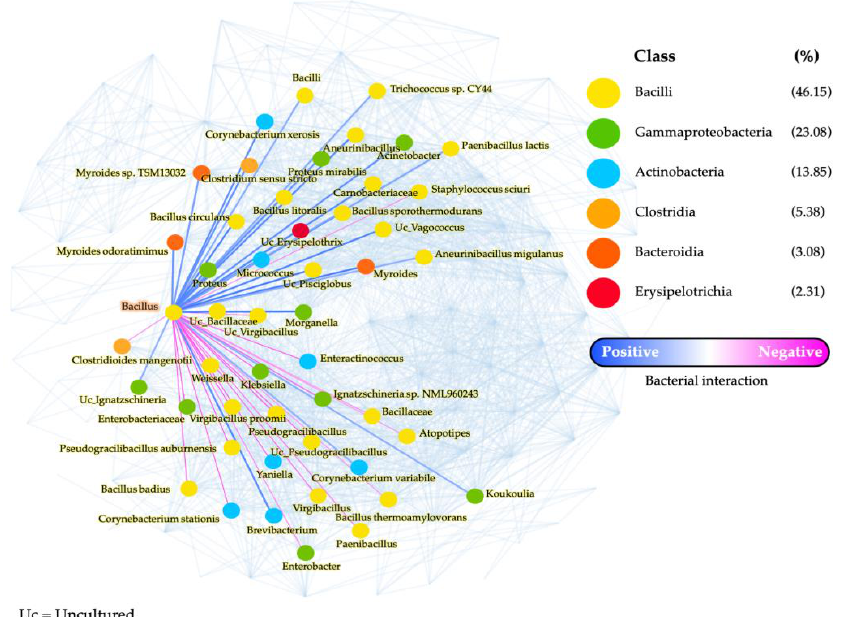
Figure 5. Part of the bacterial correlation network analysis, showing positive and negative correlations between Bacillus and another 27 bacterial taxa belonging to six classes, which were present in the fermented soybean products of the Karen, Lawa, and Shan.